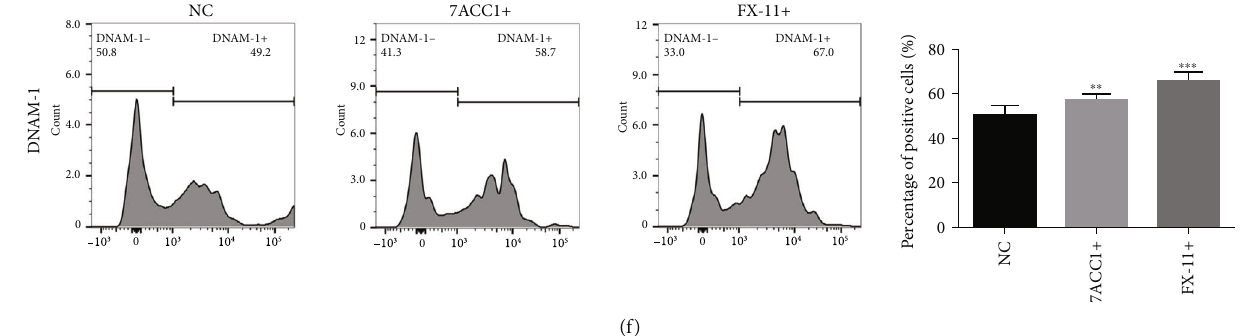
Figure 8: Lactate production mediated by LDHA attenuates the function of NK cells in vivo. (a) Tumors were obtained from C57BL/6 mice treated with 7ACC1 or FX-11 by intraperitoneal injection. (b) The growth curve of tumor volume from C57BL/6 mice. (c) The average weight of tumors from C57BL/6 mice treated with 7ACC1 or FX-11 by intraperitoneal injection. (d – f) The percentages of NKG2D-, NKp46-, and DNAM-1-positive NK cells in the blood of C57BL/6 mice treated with 7ACC1 or FX-11 by intraperitoneal injection. The data are presented as the mean ± SD from three independent experiments. ∗ P ≤ 0 : 05 , ∗∗ P ≤ 0 : 01 , and ∗∗∗ P ≤ 0 : 001